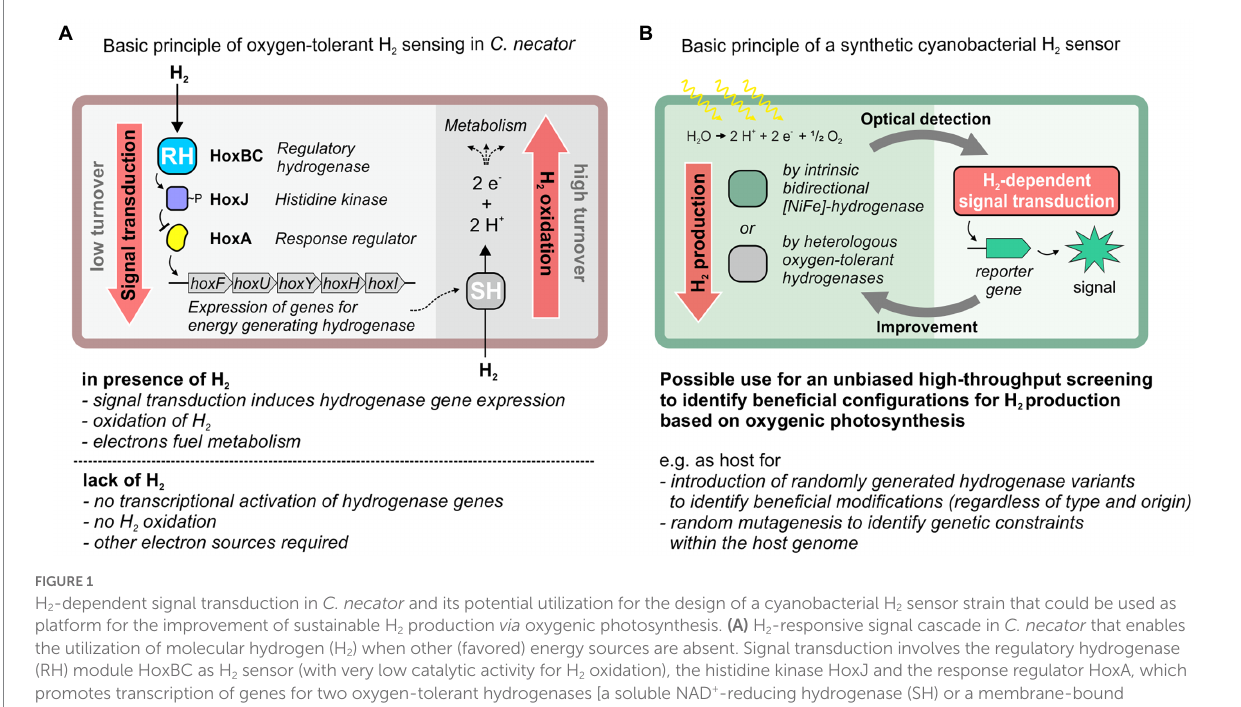
FIGURE 1 H 2 -dependent signal transduction in C. necator and its potential utilization for the design of a cyanobacterial H 2 sensor strain that could be used as platform for the improvement of sustainable H 2 production via oxygenic photosynthesis. (A) H 2 -responsive signal cascade in C. necator that enables the utilization of molecular hydrogen (H 2 ) when other (favored) energy sources are absent. Signal transduction involves the regulatory hydrogenase (RH) module HoxBC as H 2 sensor (with very low catalytic activity for H 2 oxidation), the histidine kinase HoxJ and the response regulator HoxA, which promotes transcription of genes for two oxygen-tolerant hydrogenases [a soluble NAD + -reducing hydrogenase (SH) or a membrane-bound hydrogenase (MBH)]. These hydrogenases show high activity toward H 2 oxidation and are used for energy-conservation. (B) Potential application of this H 2 -responsive signal cascade to drive reporter gene expression in cyanobacteria. This would enable optical detection of H 2 that was produced by other hydrogenases using electrons obtained by light-driven water oxidation. This screening platform could facilitate strain engineering with diverse strategies, e.g., improving hydrogenase properties by (repeated) rational design or random mutagenesis, toward an improved photosynthetic H 2 production. SH, soluble NAD + -reducing hydrogenase; RH, regulatory